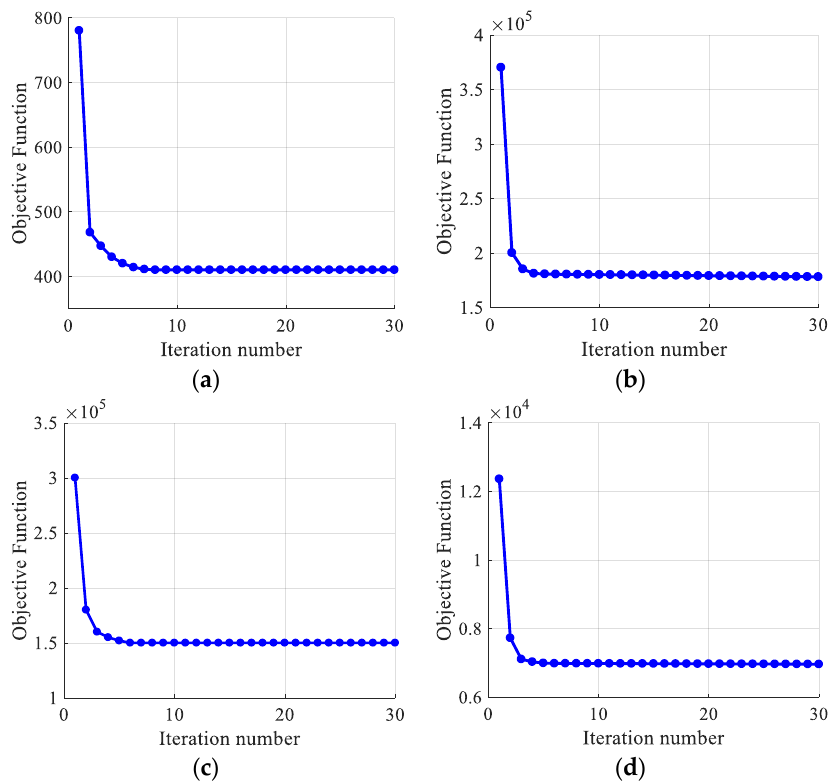
Figure 7. The convergence analysis of LHH: ( a ) UC Merced Land Use Dataset (UCMD); ( b ) SAT4; ( c ) SAT6; and ( d ) CIFAR10.